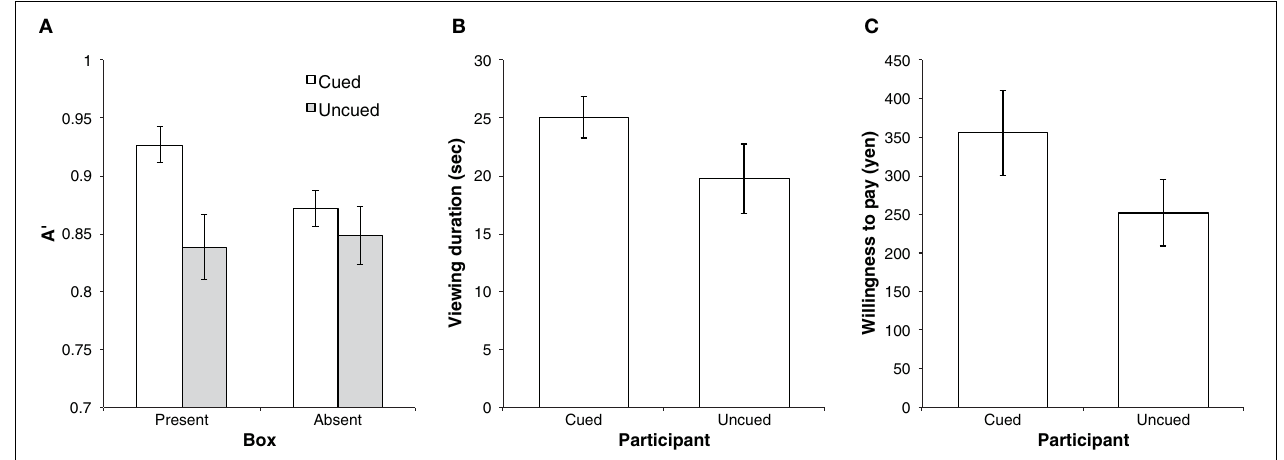
FIGURE 2 | The experimental results for (A) recognition performance, (B) viewing duration of each exhibit, and (C) willingness to pay. Error bars denote standard errors of the means.